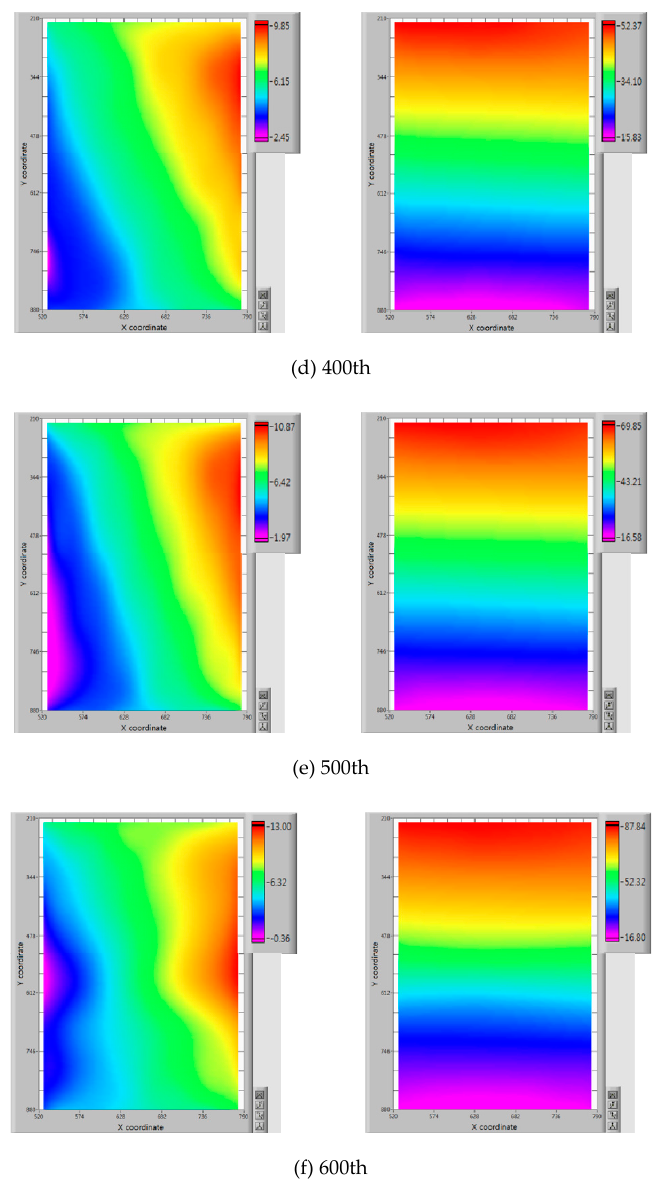
Figure 9. The results of displacements distribution by the newly configured FFT DIC algorithm. ( Left : x-direction, Right : y-direction deformation